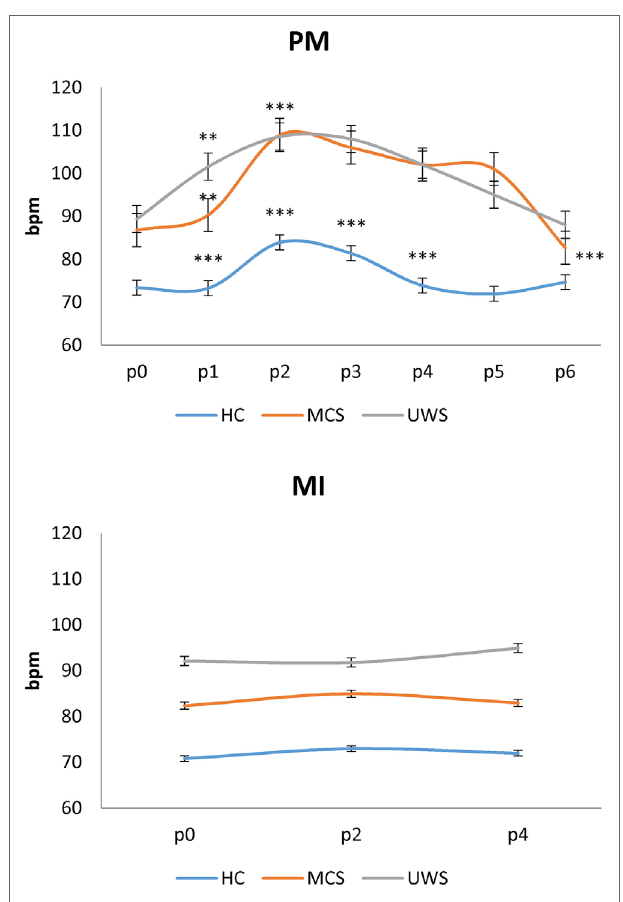
FigUre 3 | Shows mean ( ± SD; vertical error bar) heart rate values [in beats per minute (bpm)] during passive movement (PM) and motor imagery (MI) tasks for each group [healthy controls (HC), minimally conscious state (MCS), and unresponsive wakefulness syndrome (UWS)] across the hand positions (p) explored. There was a significant difference at p0 (baseline) between the bpm values of HCs and patients with disorders of consciousness ( p < 0.001), and between patients with MCS and UWS ( p = 0.01). PM induced a significantly different bpm modulation at each p among the groups ( p < 0.001). On the contrary, MI did not induce any significant bpm change. *Refer to the significance of intragroup pulsatility index change at each p as compared to the previous one